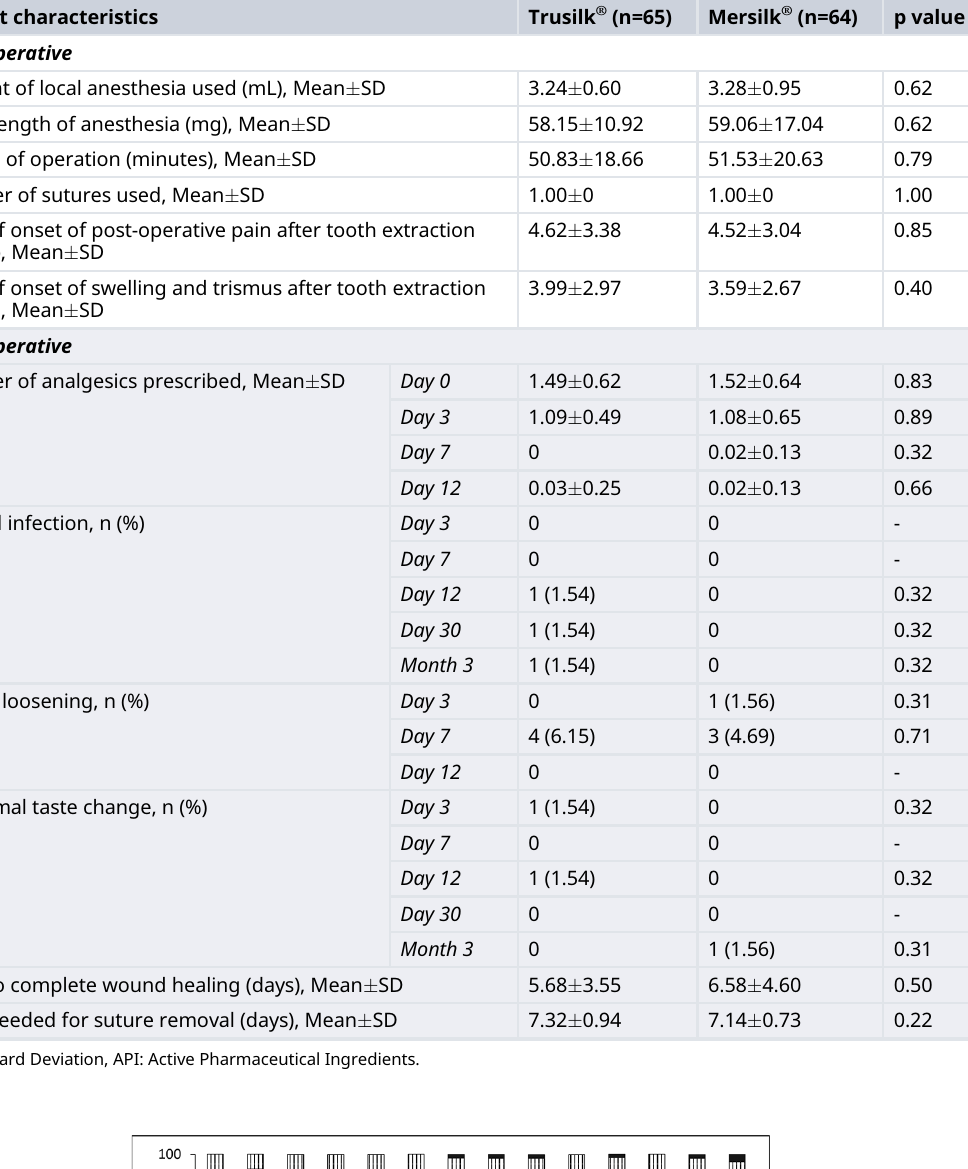
Table 2. Intraoperative and post-operative profile of the study participants.